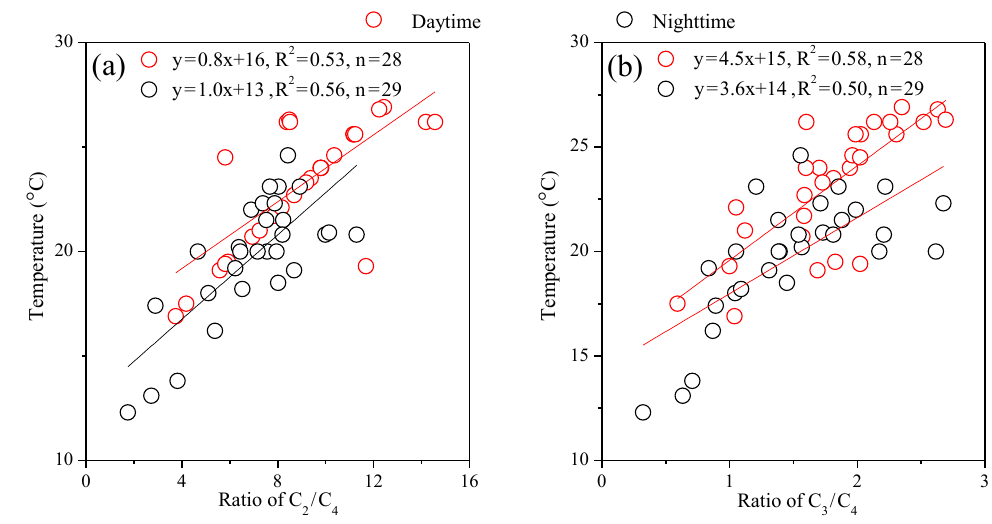
Figure 5. Linear fit regression for temperature ( T ) with mass ratios of (a) C 2 / C 4 and (b) C 3 / C 4 (see the abbreviations in Table